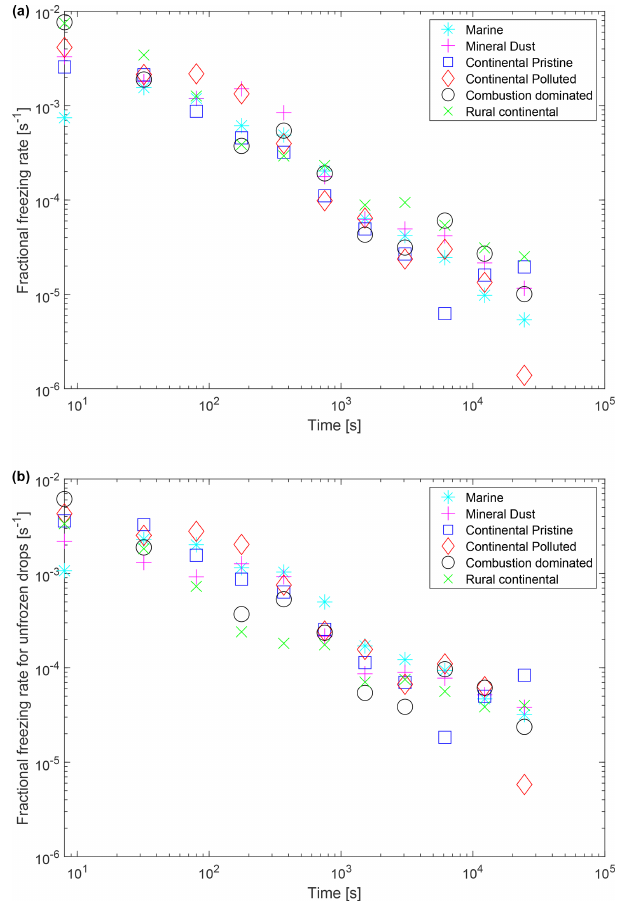
Figure 11. (a) Fractional rate of change of the frozen frac- − 1 tion, f ice (cid:0) t ∗ (cid:1) d f ice (cid:0) t ∗ (cid:1) / d t ∗ , plotted as a function of time since the start of the isothermal phase for the marine, mineral-dust- influenced, continental pristine, continental polluted, combustion- dominated and rural continental samples. This was estimated by a finite difference approximation to the derivative for consecutive val- ues in the time series of the data. Only positive estimates of these rates are plotted. (b) Also shown is the corresponding absolute mag- nitude of the fractional rate of change of the number of unfrozen drops, ( f ice (cid:0) t ∗ = 10h (cid:1) − f (cid:0) t ∗ (cid:1) ) − 1 d f ice / d t ∗ , considering only the drops that eventually freeze after 10h in the isothermal experiment.